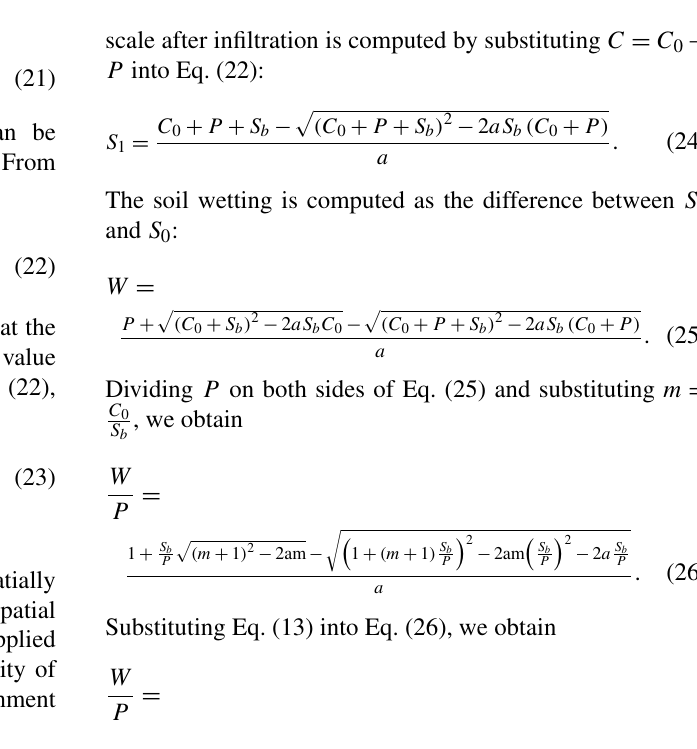
Figure 4. The cumulative distribution functions (CDFs) with differ- ent parameter values: (a) the proposed distribution function repre- sented by Eq. (26) and (b) the generalized Pareto distribution of the VIC model represented by Eq.